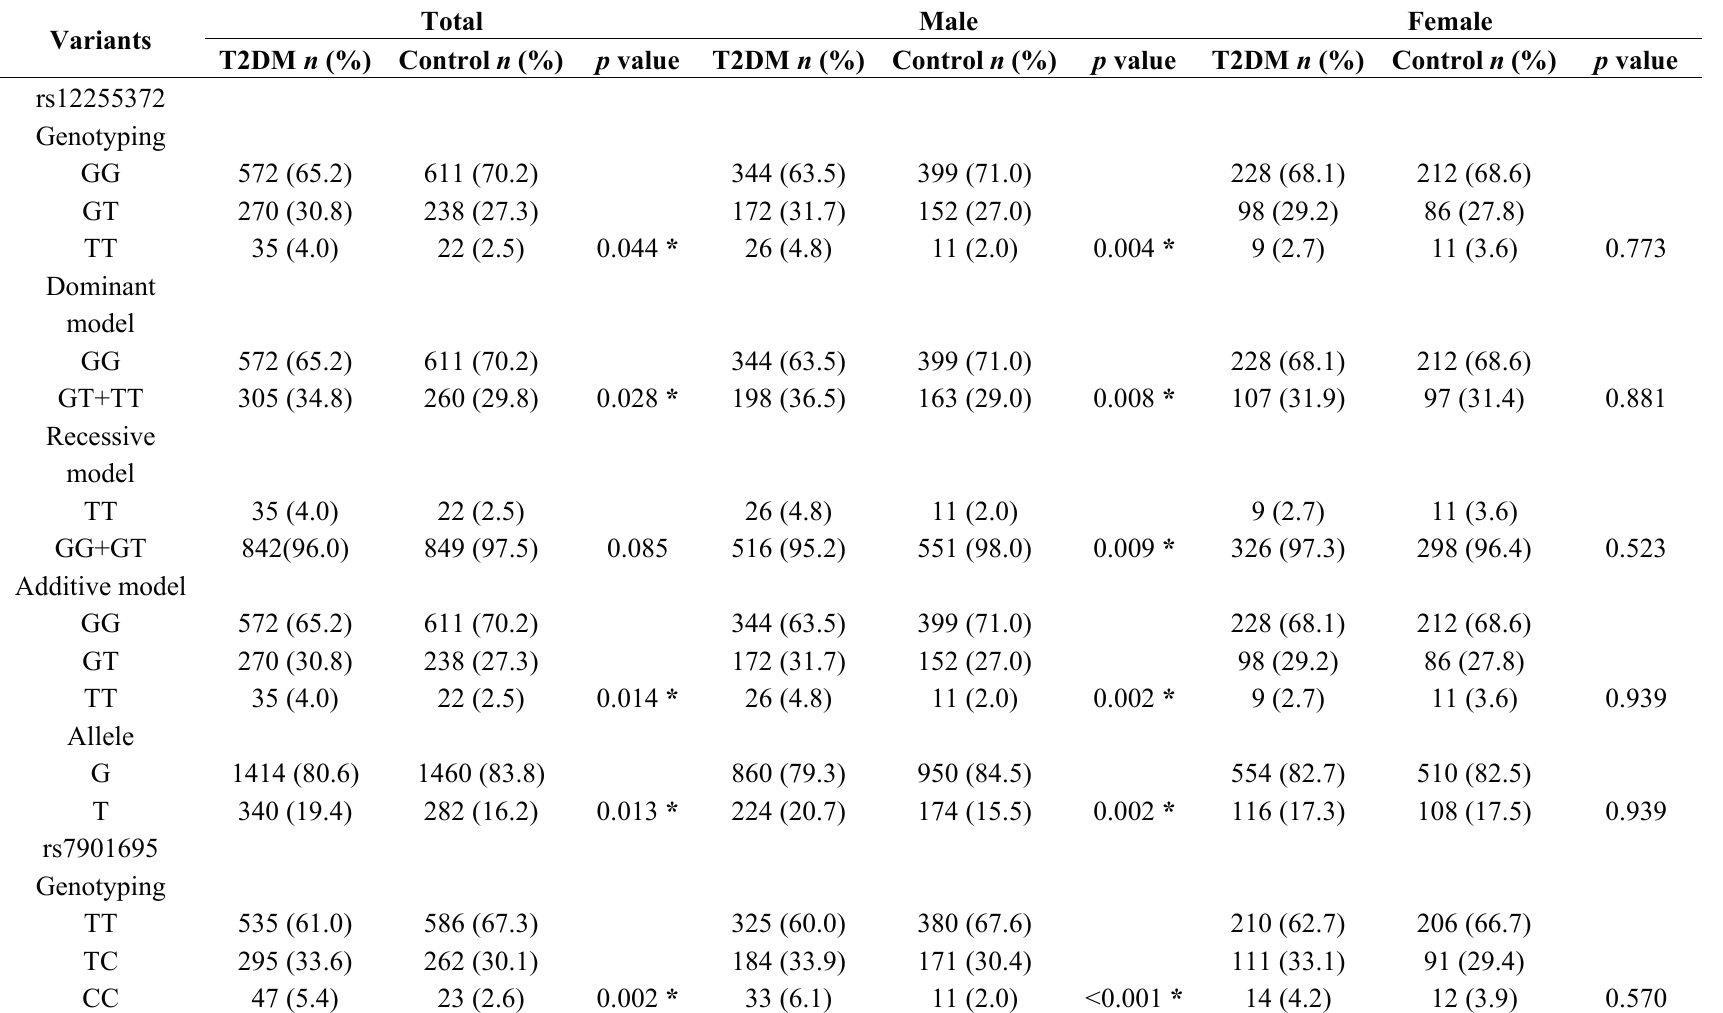
Table 3. Genotype and allele distributions in patients with T2DM and control